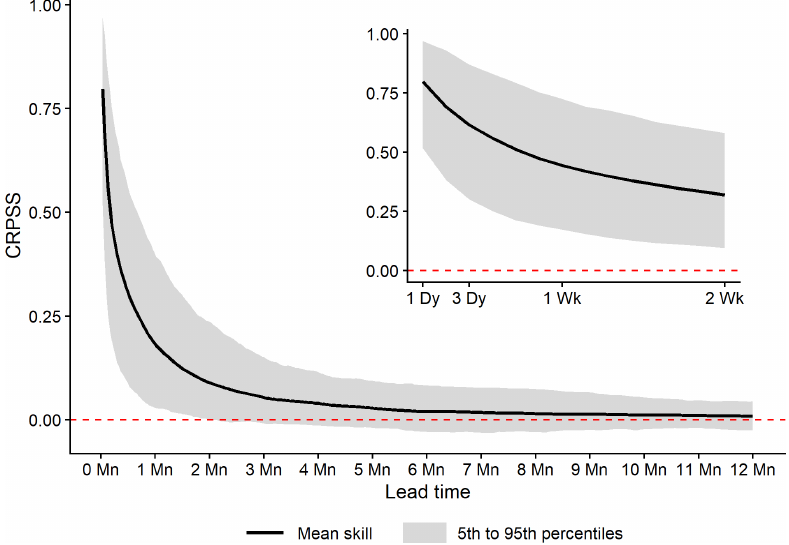
Figure 3. Mean ESP CRPSS values across all 46 study catchments, 12 forecast initialisation months, and all 365 lead times, with short and extended lead times shown inset for readability. Variations in skill scores across all catchments at each lead time are given by the 5th and 95th percentile ensemble